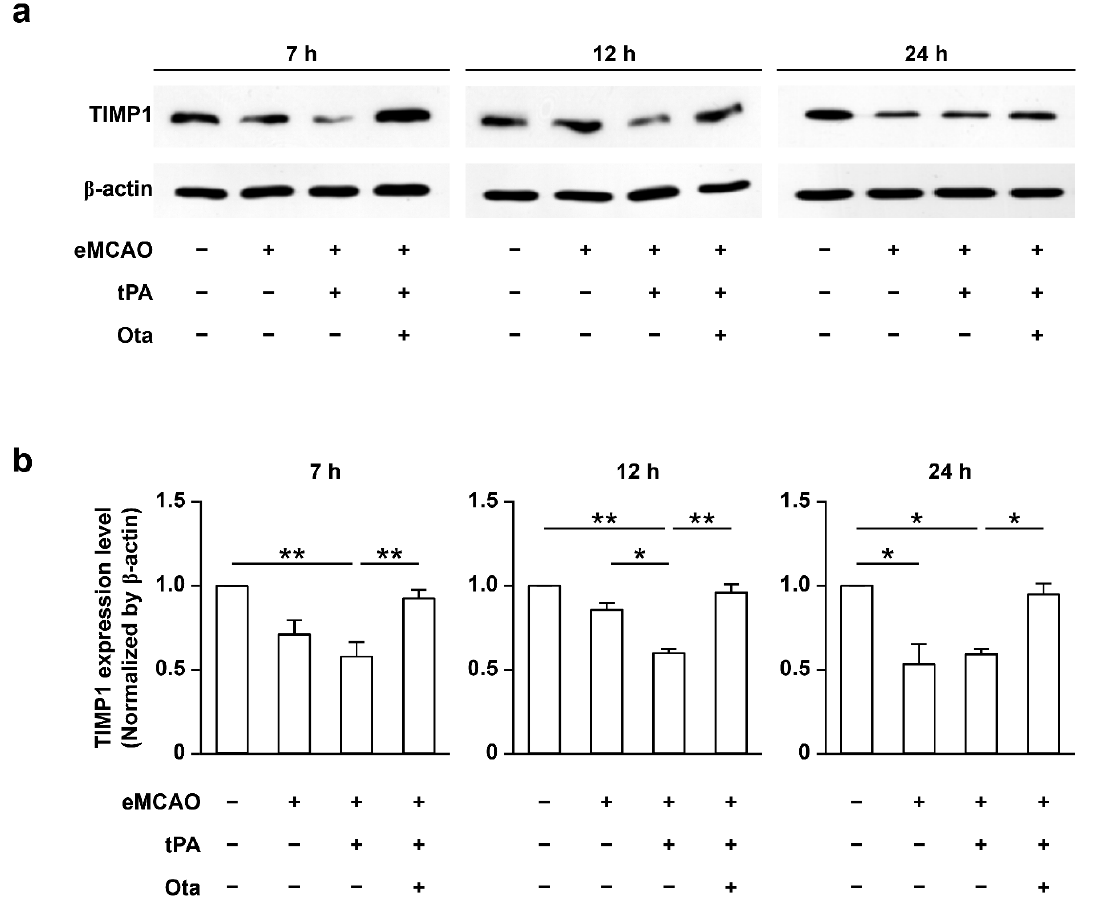
Figure 4. Restoration of TIMP1 levels in embolic brains by otaplimastat (Ota). ( a ) Rats were treated with rtPA at 6 h after eMCAO onset and TIMP1 levels determined via Western blot at 7, 12 and 24 h. ( b ) Integrated density values of TIMP1 protein levels were normalized to that of β -actin. Data are expressed as means ± S.D. and analyzed with Kruskal–Wallis followed by Mann–Whitney test ( n = 6, * p < 0.05 and ** p < 0.01).